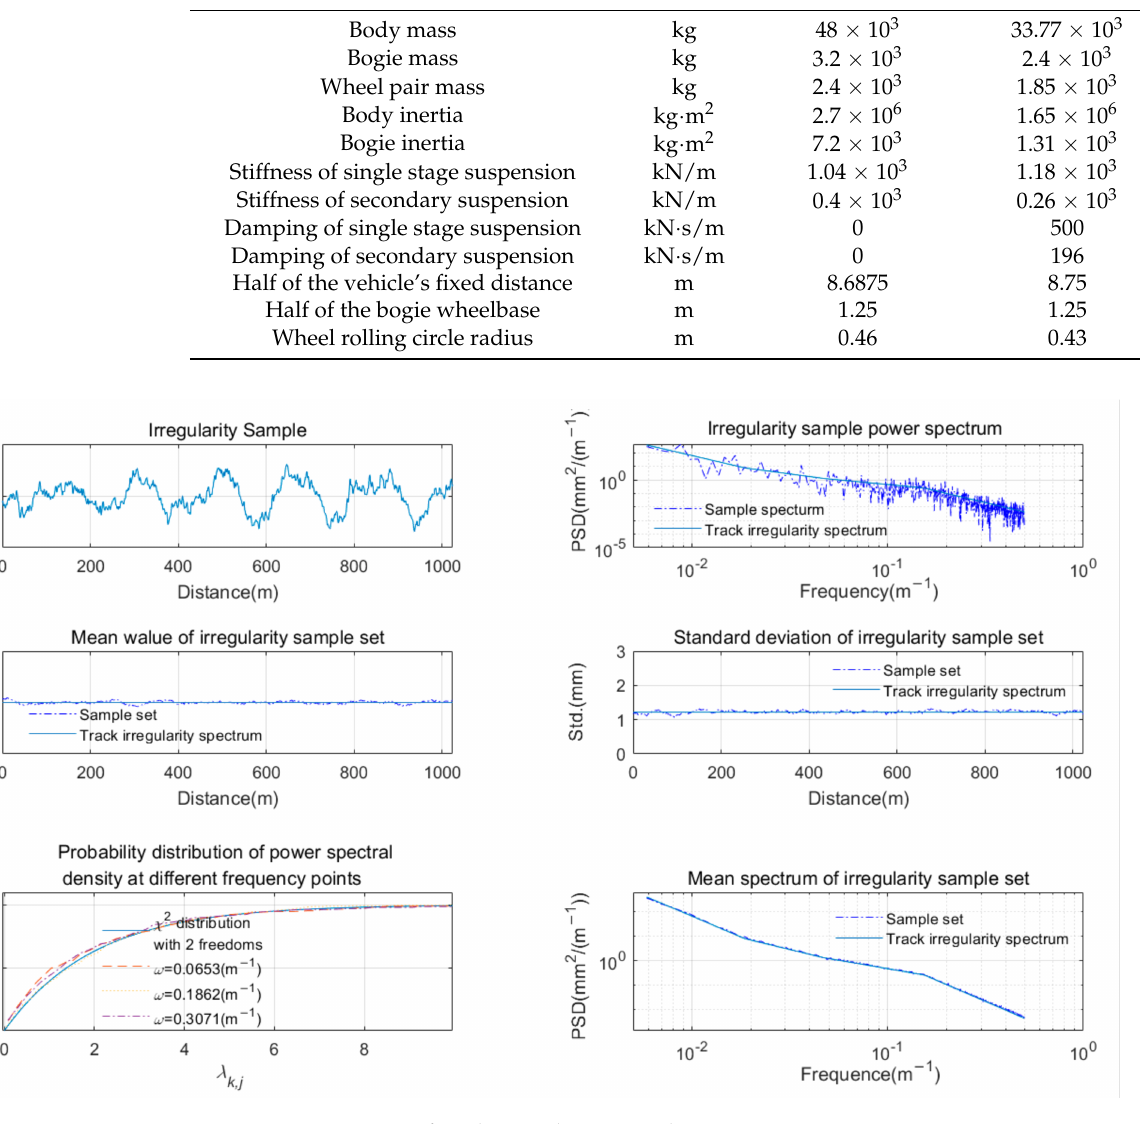
Figure 3. Comparison of track irregularity samples.